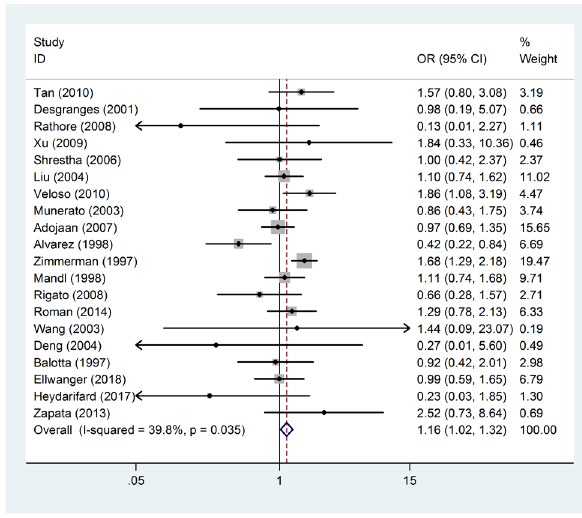
Figure 2: Forest plots demonstrating the association between CCR5-delta32 polymorphism and HIV-1 infection susceptibility in the CCR5-delta32 heterozygote